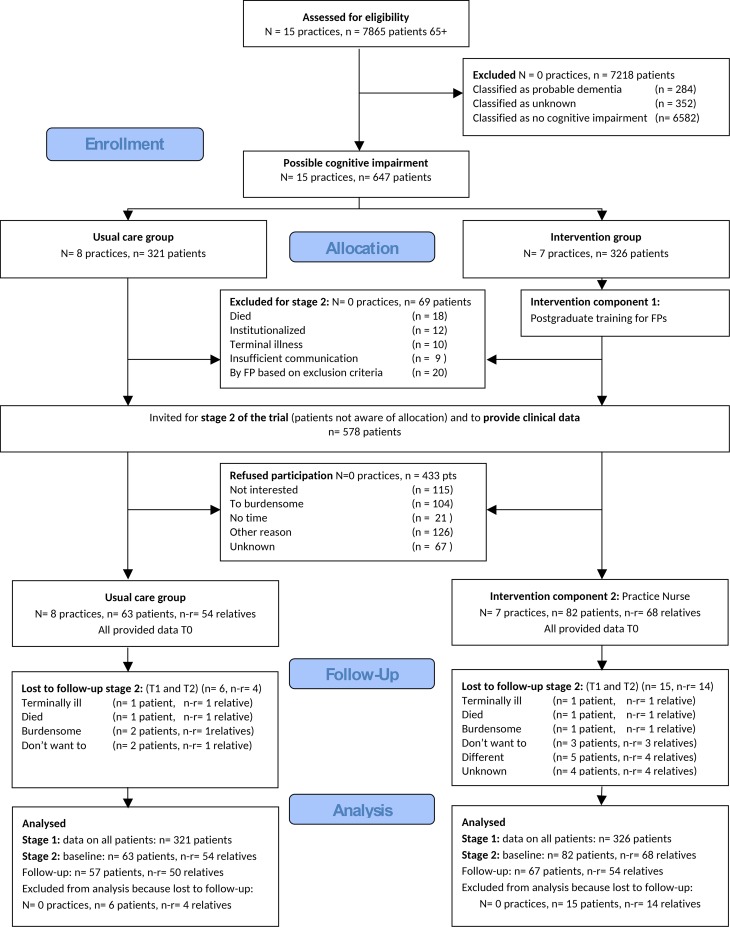
CONSORT Flowdiagram.